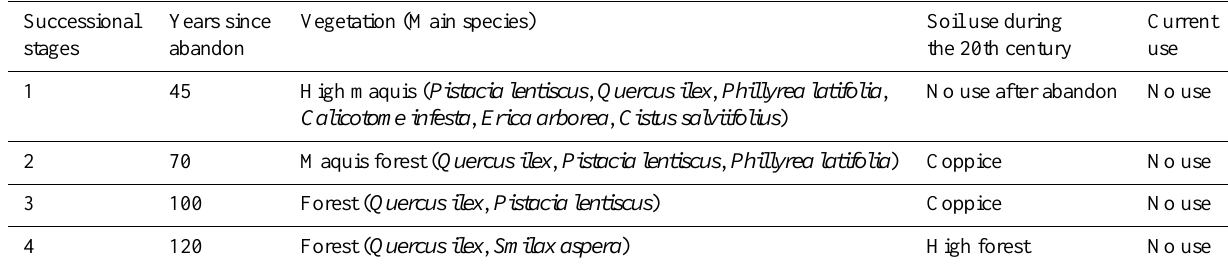
Table 1. Characteristics of litter collected in Pantelleria island. Successional Years since Vegetation (Main species) Soil use during Current stages abandon the 20th